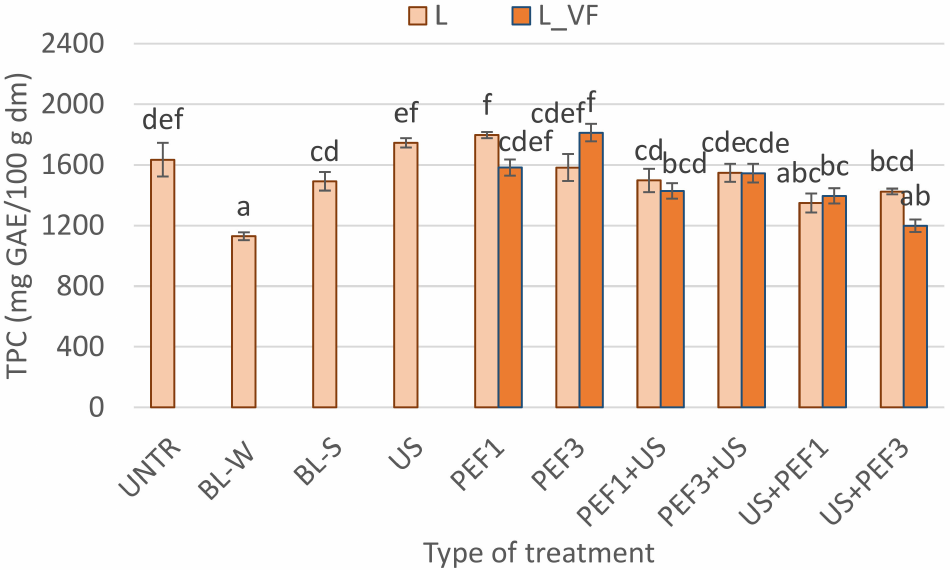
Figure 4. Total phenolic content (TPC) in lyophilized red bell peppers treaded with traditional treat- ment (BL_W—blanching in water, BL_S—steam blanching), novel single treatment (US—sonication for 30 min, PEF_1—pulsed electric field with energy input 1 kJ/kg, PEF_3—pulsed electric field with energy input 3 kJ/kg) or novel hybrid treatment (PEF+US, US+PEF), preceded by shock freezing (L) and vacuum freezing (L_VF). Data are presented as a mean from 3 repetitions with error bars as a standard deviation (SD), data with different letters differ significantly (Tukey’s HSD, p <